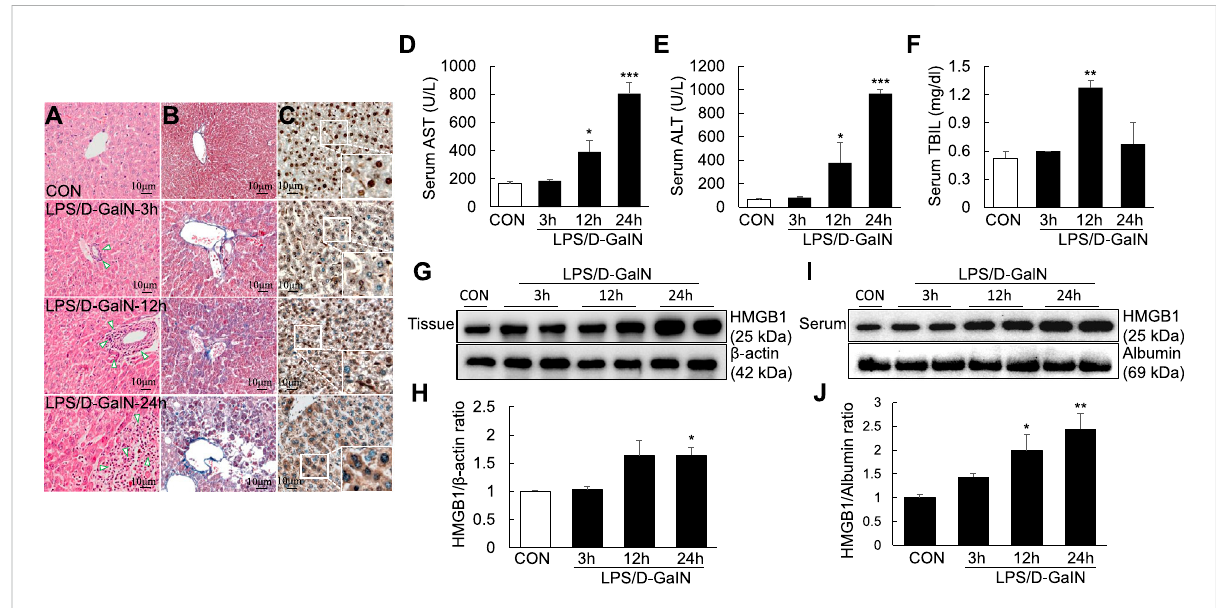
FIGURE 1 ALI and extracellular levels of HMGB1 in the LPS/D-GaIN-induced ALF mouse model. LPS (10 μ g/kg) and D-GalN (600 mg/kg) were administered intraperitoneally (i.p.) to BALB/c mice for 3, 12, and 24 h. We determined the extent of in fl ammatory cell in fi ltration (A) as well as liver cell necrosis and fi brosis (B) via H and E and Masson staining. Extracellular levels of HMGB1 were determined via immunohistochemistry (C) . Representative images and results are presented as means ± SEM ( n = 3). We measured AST, ALT, and TBIL levels in the serum (D – F) and examined HMGB1 levels in the liver (G,H) and serum (I,J) by western blotting ( n = 3). * p < 0.05, ** p < 0.01, *** p < 0.001 vs.